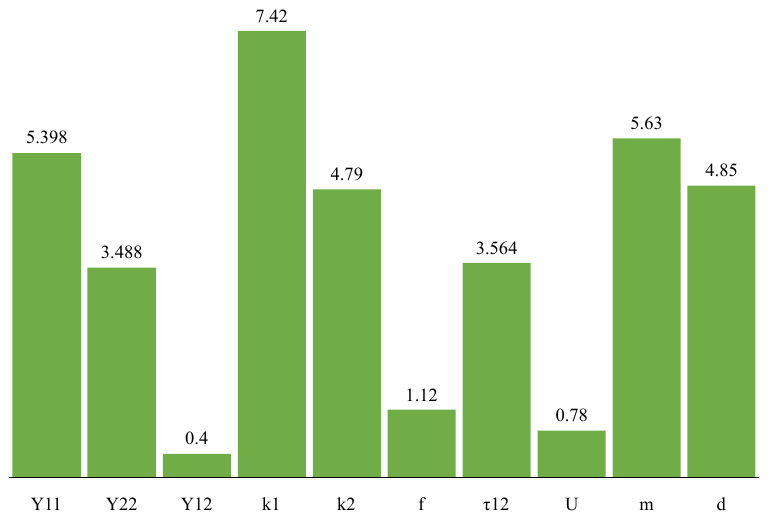
Figure 6. Dynamic characteristics of the external wall of the ventilated façade with the optimal layer thickness.